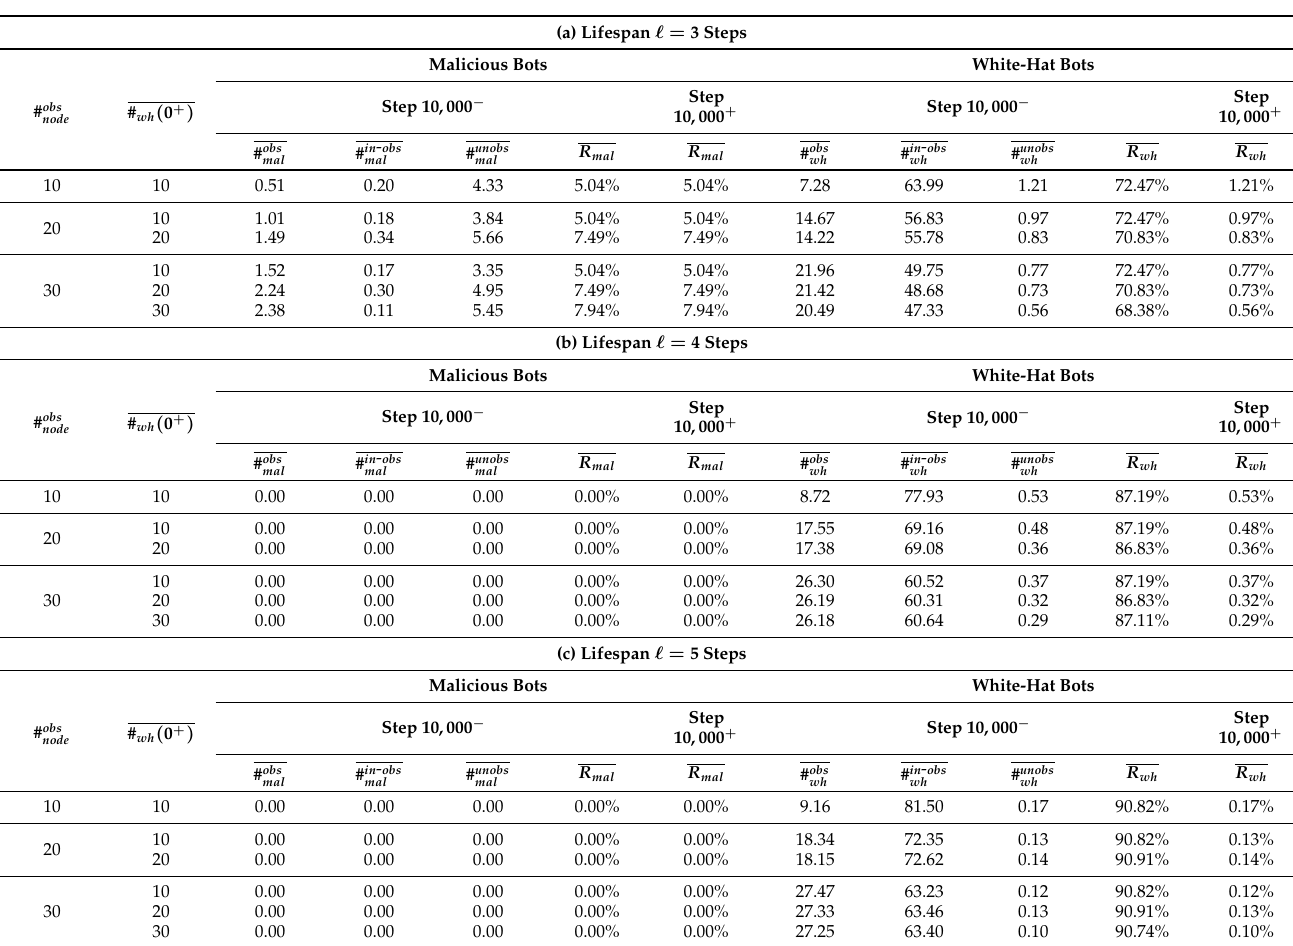
Table 3. Simulation results in the general